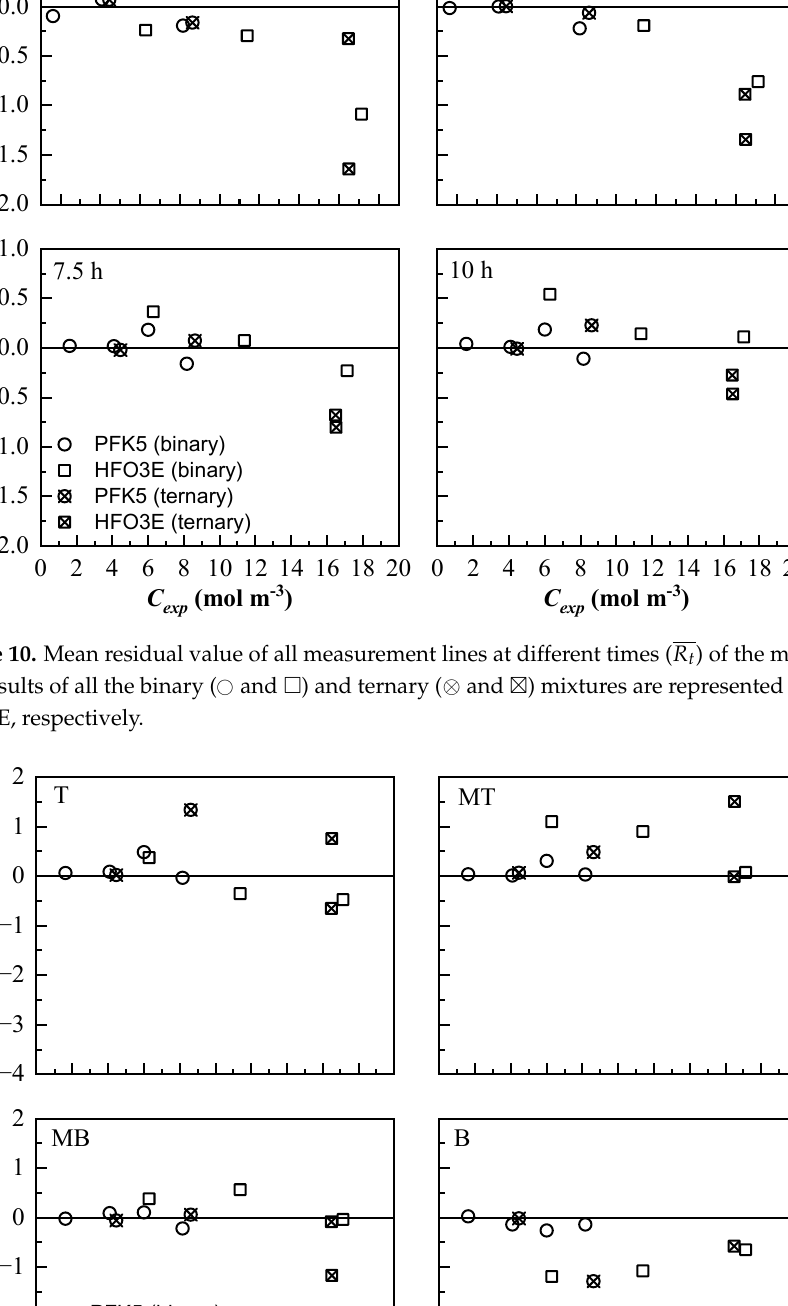
Table 8. Minimum and maximum absolute residual values of the mixtures. Mixture